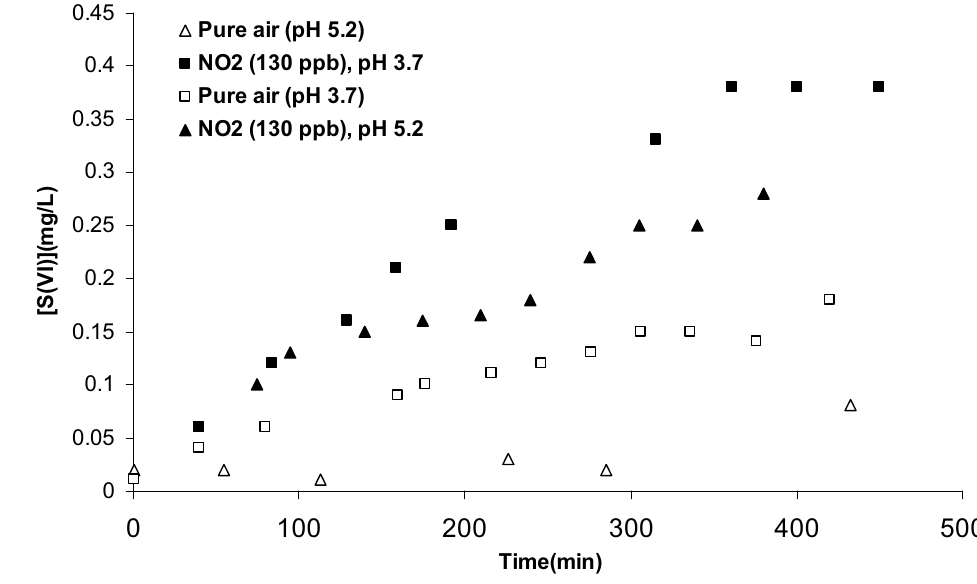
Fig. 3 – Time dependence of [S(VI)] for S(IV) oxidation, [S(IV)] ◦ = 0.8 mg/L, T = 22 ◦